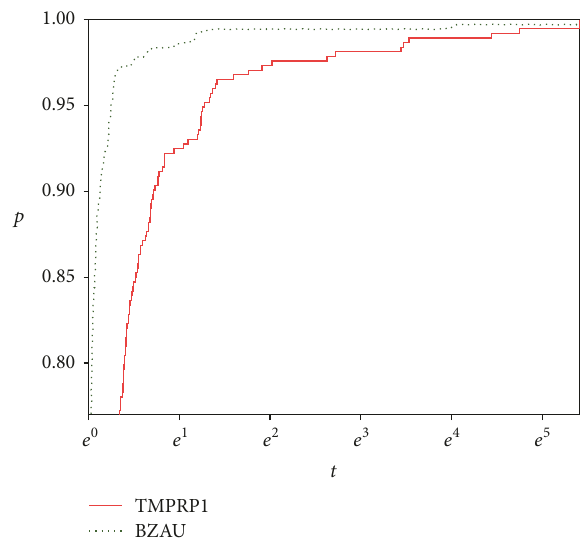
Figure 2: Performance profiles based on the CPU